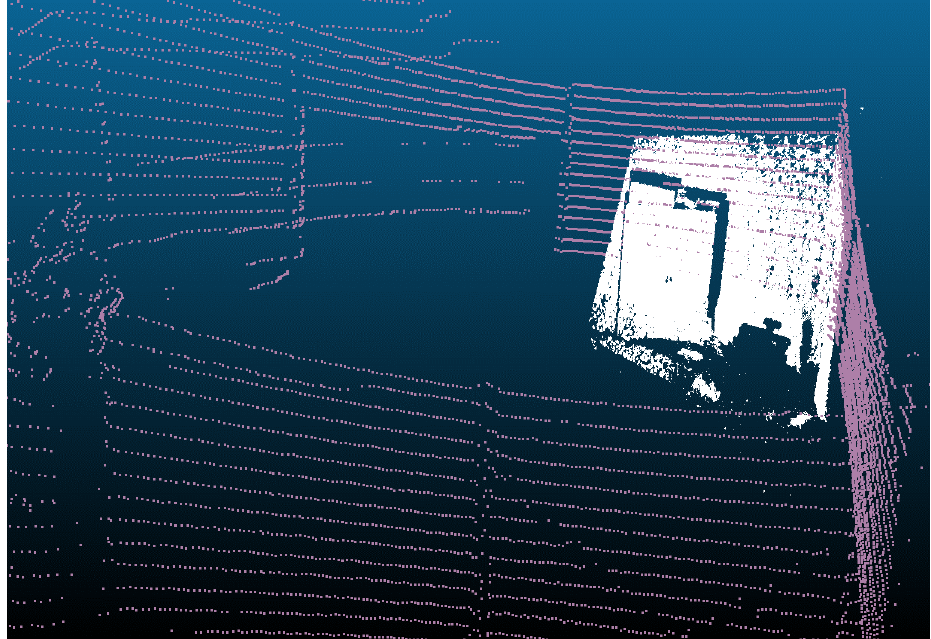
Figure 6. Alignment of cloud points LiDAR of RealSense L515 camera (white) to the cloud point of the Vehicle LiDAR